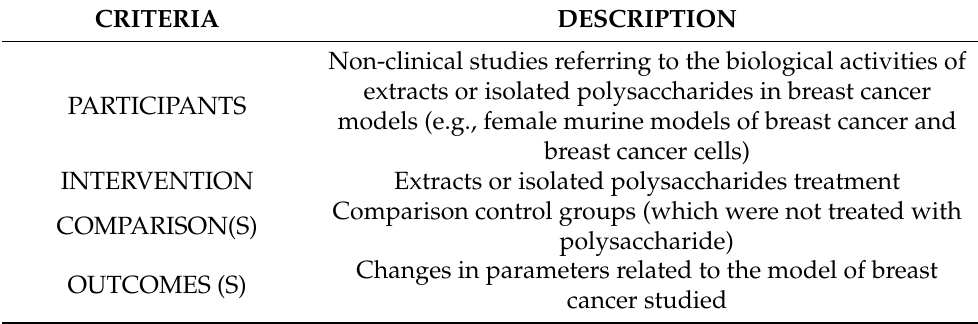
Table 1. Description of the PICO (Participants, Intervention, Comparison, and Outcome) criteria used in the present systematic